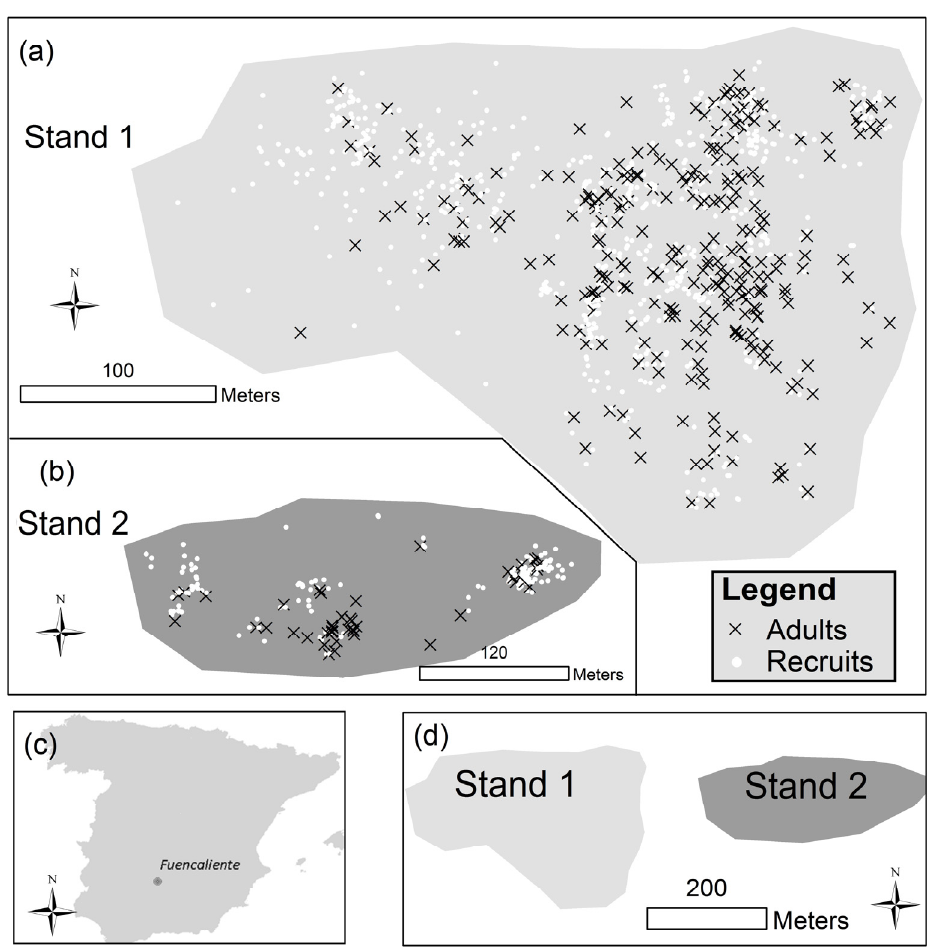
Figure 1. Maps of the maritime pine population of Fuencaliente. ( a ) Location of adults and recruits in Stand 1 and ( b ) in Stand 2; ( c ) Location of Fuencaliente population within Spain; ( d ) Location of both stands in relation to each other.